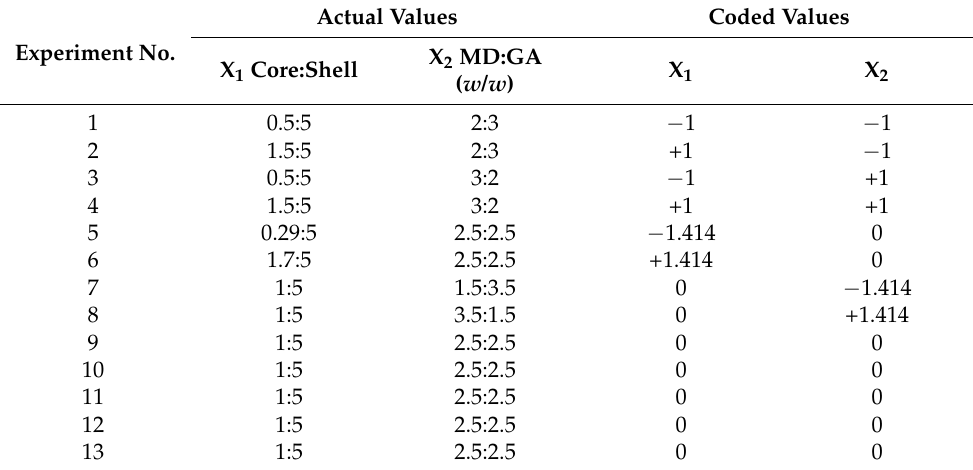
Table 1. Real and codified values used in the CCD. Actual Values Coded Experiment No.